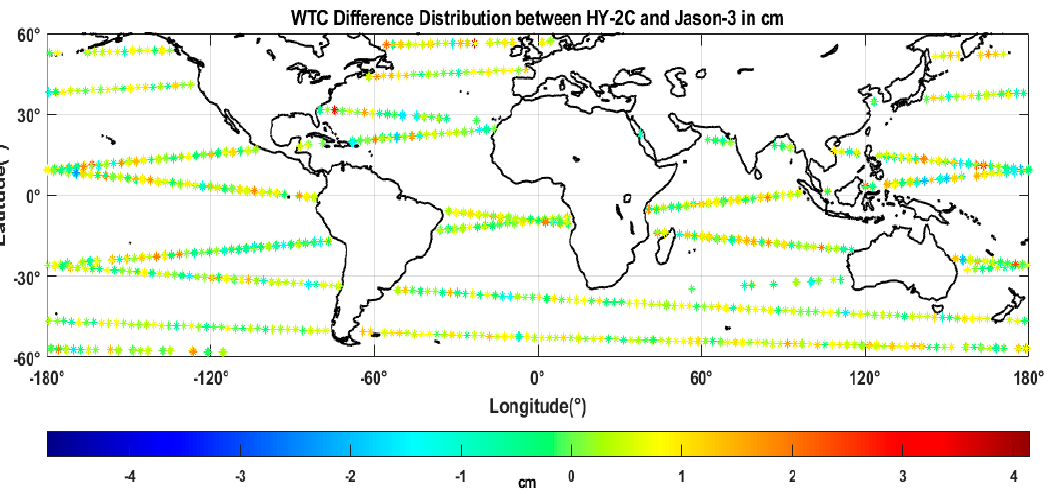
Figure 3. WTC differences in the spatial distribution of crossover points between HY-2C and Jason-3 with ∆ T < 30 min and ∆ D < 30 km (~12,788 points). The colour scale indicates WTC differences in cm.